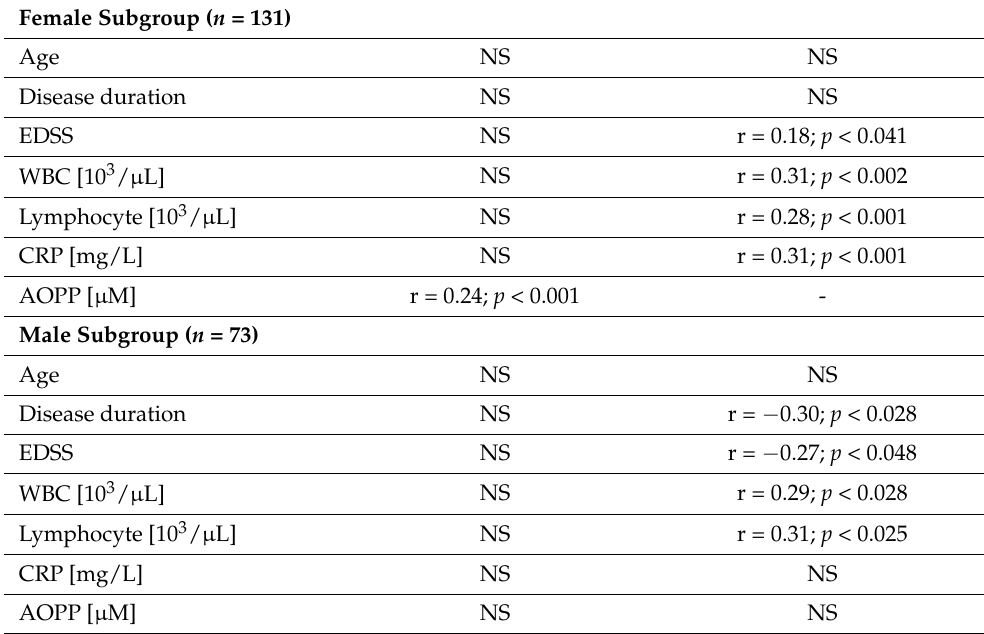
Figure 2. Statistically significant correlations between either FRAP or AOPP and WBC, lymphocytes, and CRP (for the whole study group). FRAP—ferric-reducing antioxidant power; AOPP—advanced oxidation protein products; CRP—C-reactive protein; WBC—white blood cells. All analyzed variables were compared between the subgroups of patients treated Table 3. Correlations between either FRAP or AOPP and clinical/laboratory parameters (for with particular DMT. There were statistically significant differences between these gender